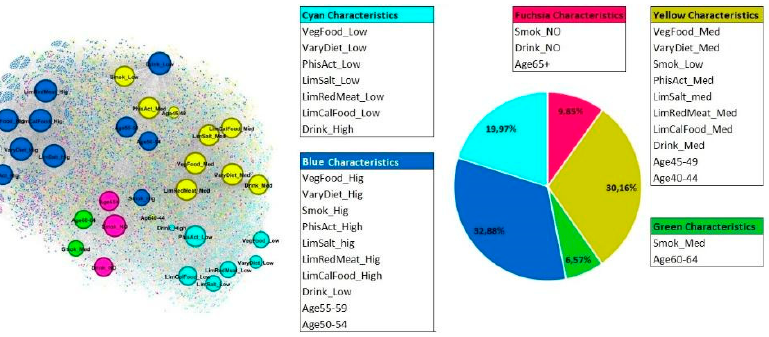
Figure 4. Graph layout and composition of communities within the profile 3. The pie chart represents the percentages of women belonging to each community.